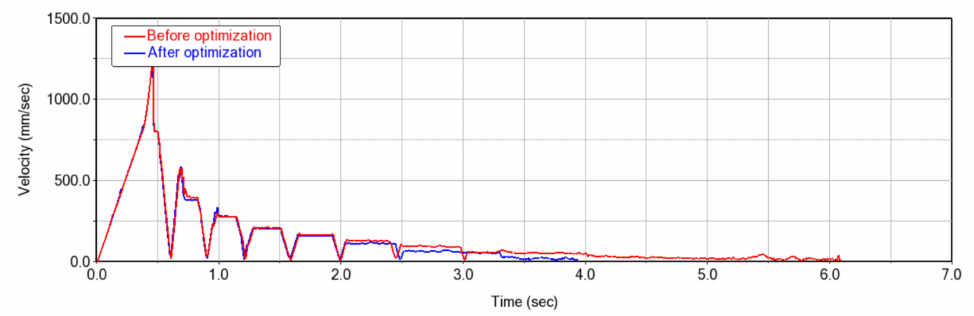
Figure 23. Comparison of the velocity of the spherical waste before and after optimization. The time taken by the spherical material to roll down from the top of the slideway to the stable and stationary position at the center of the identification table was shorter after optimization, and the speed convergence effect significantly